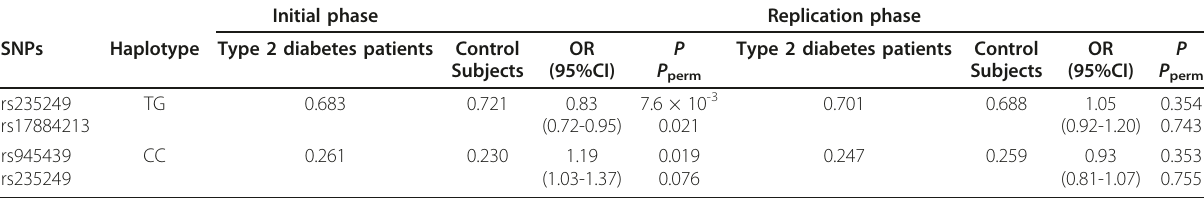
Table 3 Association of haplotypes of TNFRSF1B with type 2 diabetes in North Indian